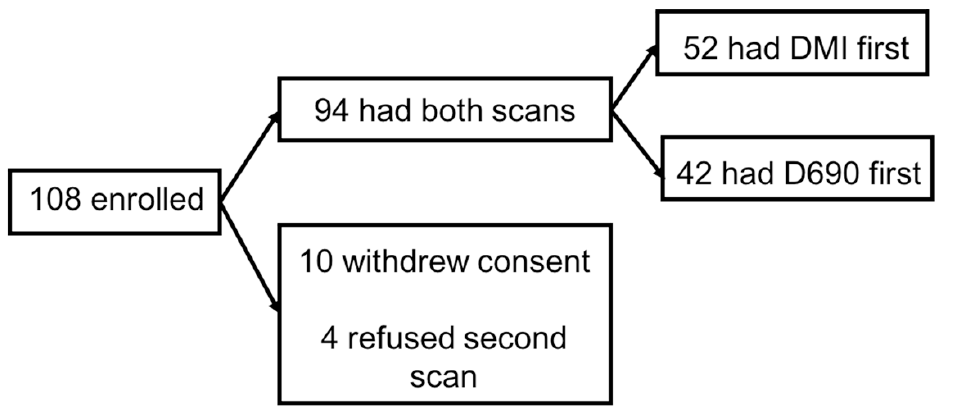
Figure 1. Flowchart of the study population. Table 1. SUV mean measurements in background organs.